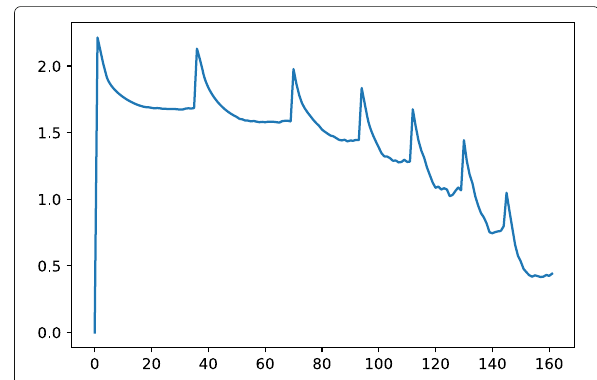
Fig. 6 Validation loss over 161 epochs for training the classifier neural nets with n 0 = 10, n n 0 = 4